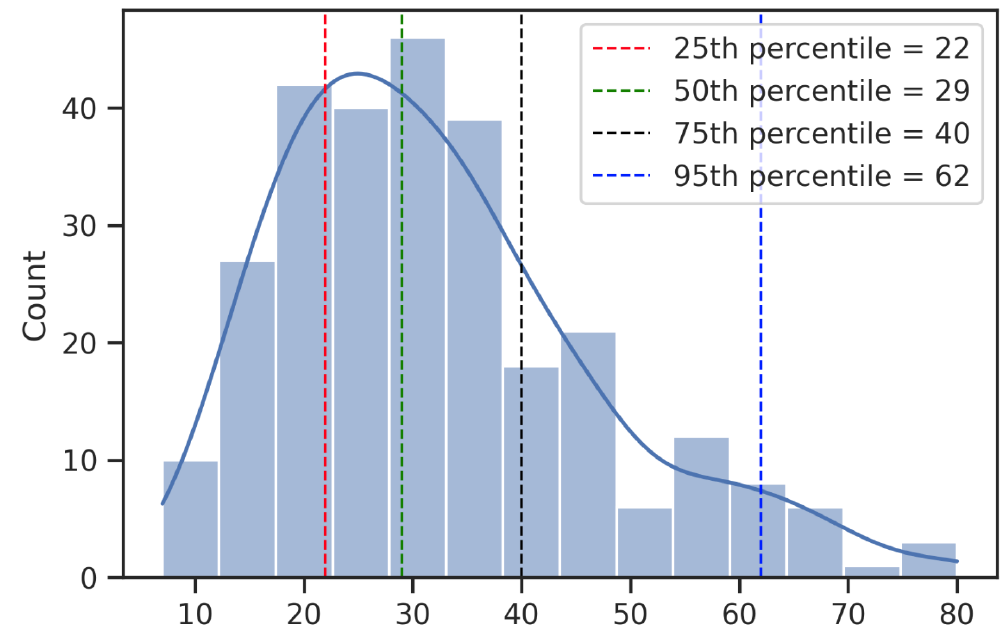
Figure 8. Figure showing the distribution of sequence lengths in the training set. The 95th percentile was found to be 62. The maximum sequence length was set to 100 for the aeroBERT-Classifier